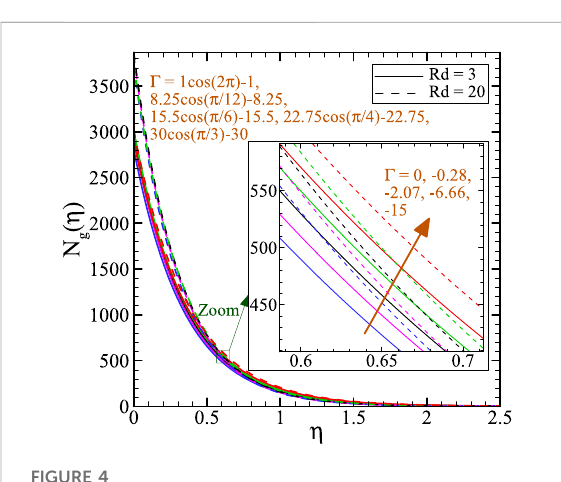
FIGURE 3 In fl uence of K on N g ( η ) for solid line (Ha = 0.5) and dash line (Ha = 25) and Rd (cid:3) 10 , Pr (cid:3) 0 . 7 , Q (cid:3) − 1 , X (cid:3) 0 . 1 , Re (cid:3) 1 , Br (cid:3) 3 , Ω (cid:3) 0 . 6.